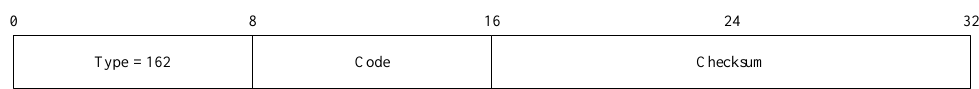
Figure 7. ICMPv6 header for SCHC control